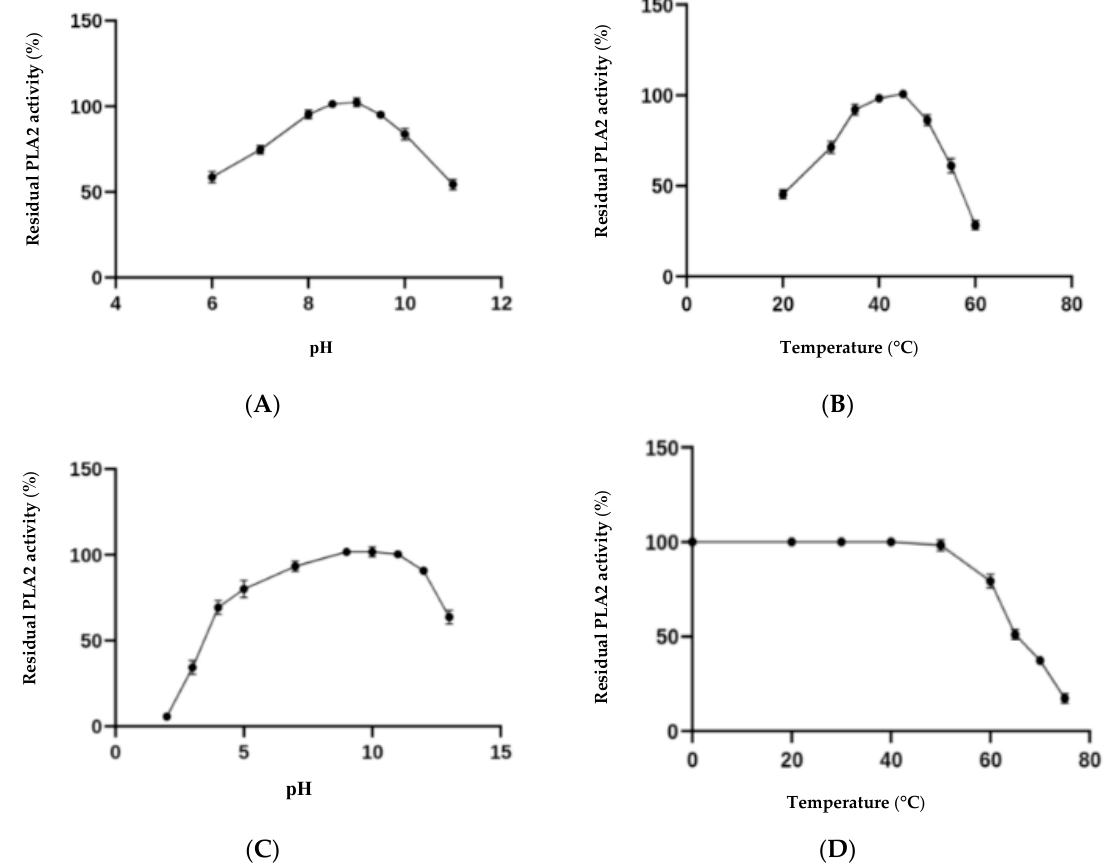
Figure 2. Evaluation of pH and temperature effect on activity ( A , B ) and stability ( C , D ) of DrPLA 2